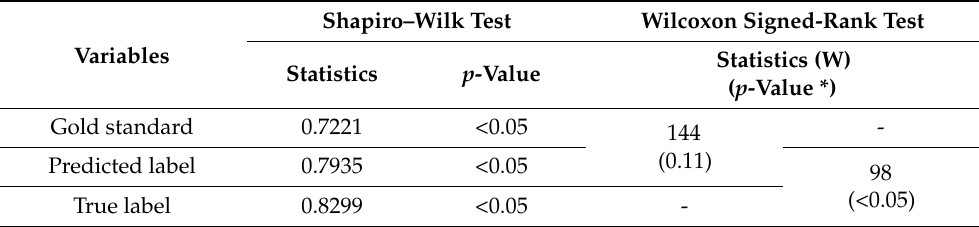
Table 4. Comparison between gold standard, predicted, and true labels.